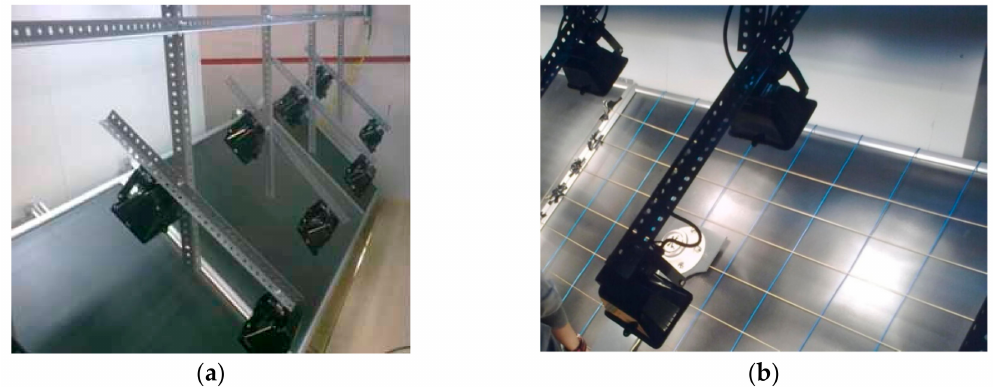
Figure 3. ( a ) View of the structure of the halogen lamps on the SAHs; and ( b ) the grid and pyranometer used for measuring